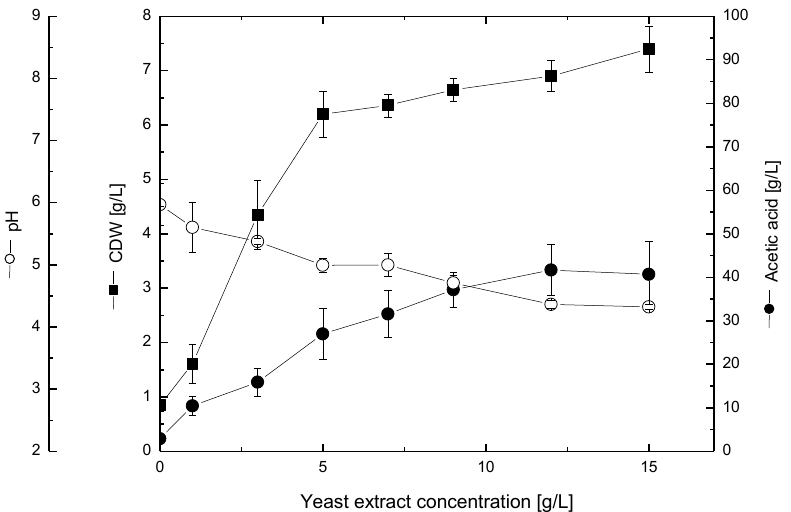
Figure 3. Effect of different yeast extract concentrations on cell growth, acetic acid production and pH during cultivation in shake flask